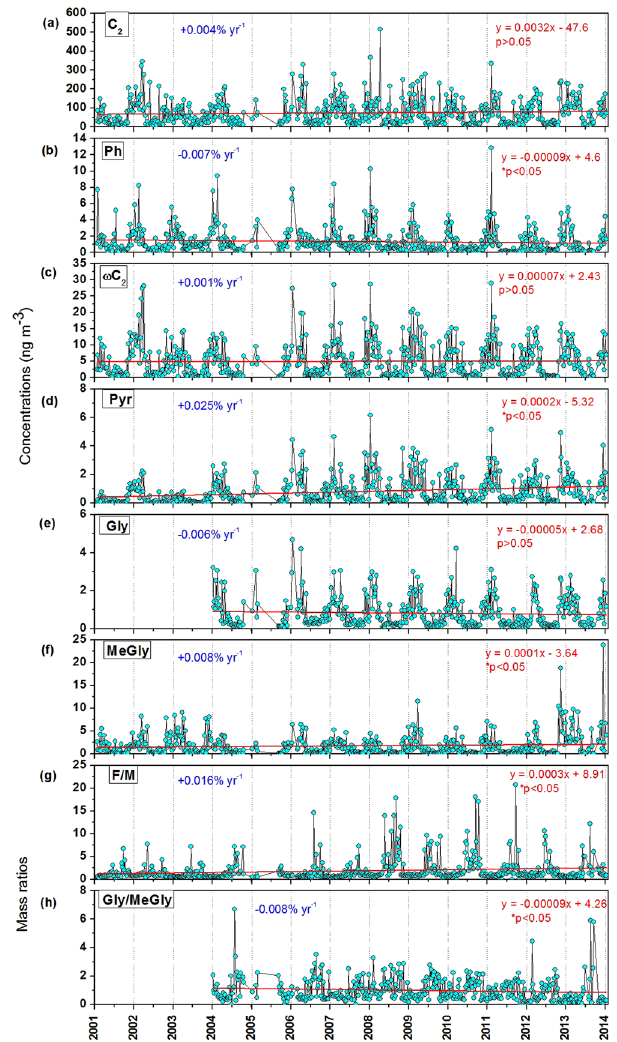
Figure 2. Trends in ( a – f ) temporal variations of water-soluble dicarboxylic acids (ng m − 3 ) and related compounds (ng m − 3 ) and ( g , h ) F/M and Gly/MeGly mass ratios in TSP aerosols collected at Chichijima Island during 2001 to 2013. Linear regression trends are given inset and applied over the whole observation period. The symbol, * , indicates the trends are significant at a 95% (p < 0.05) confidence level. The solid red line represents the trend